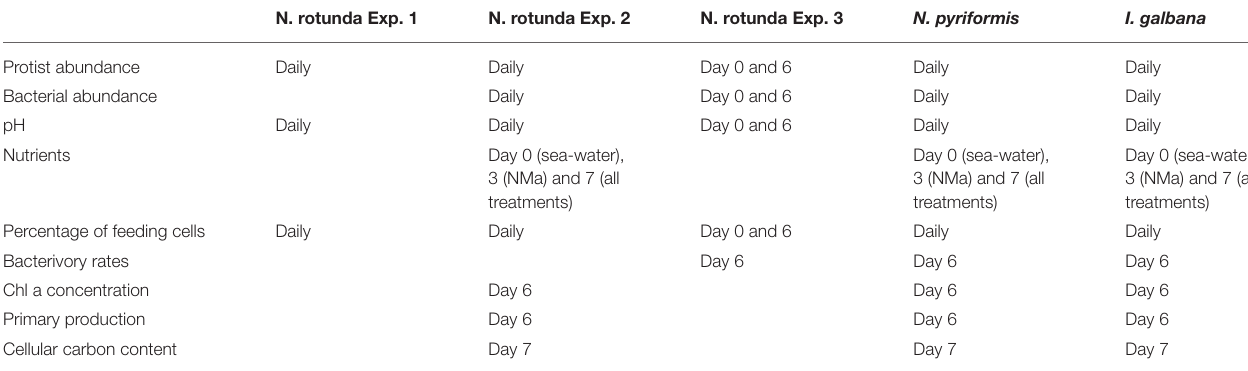
TABLE 2 | Summary of the measurements carried out in the different